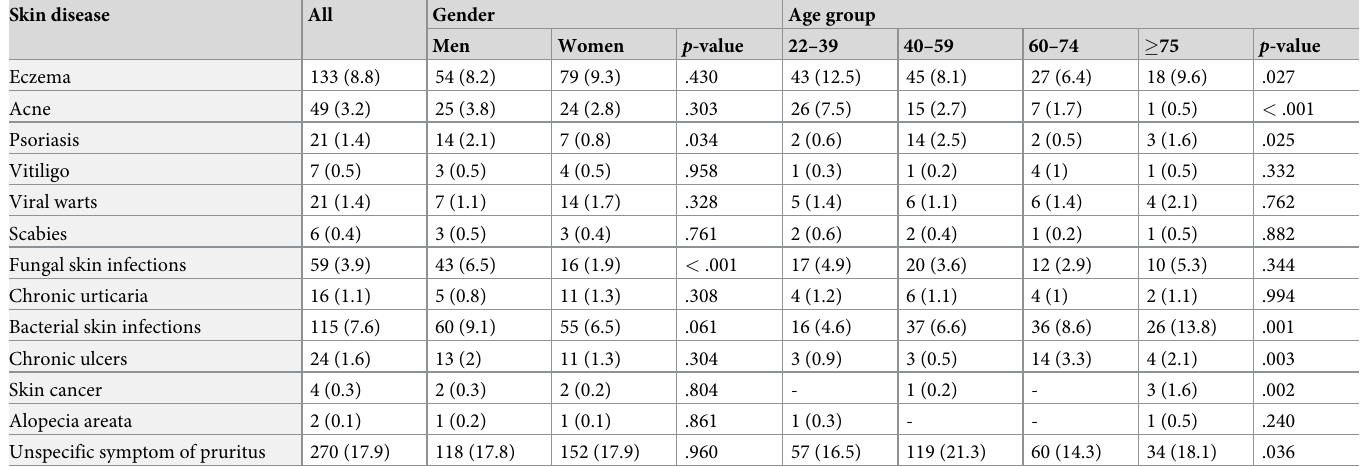
Table 2. History of individual skin diseases by gender and age group, n (%).